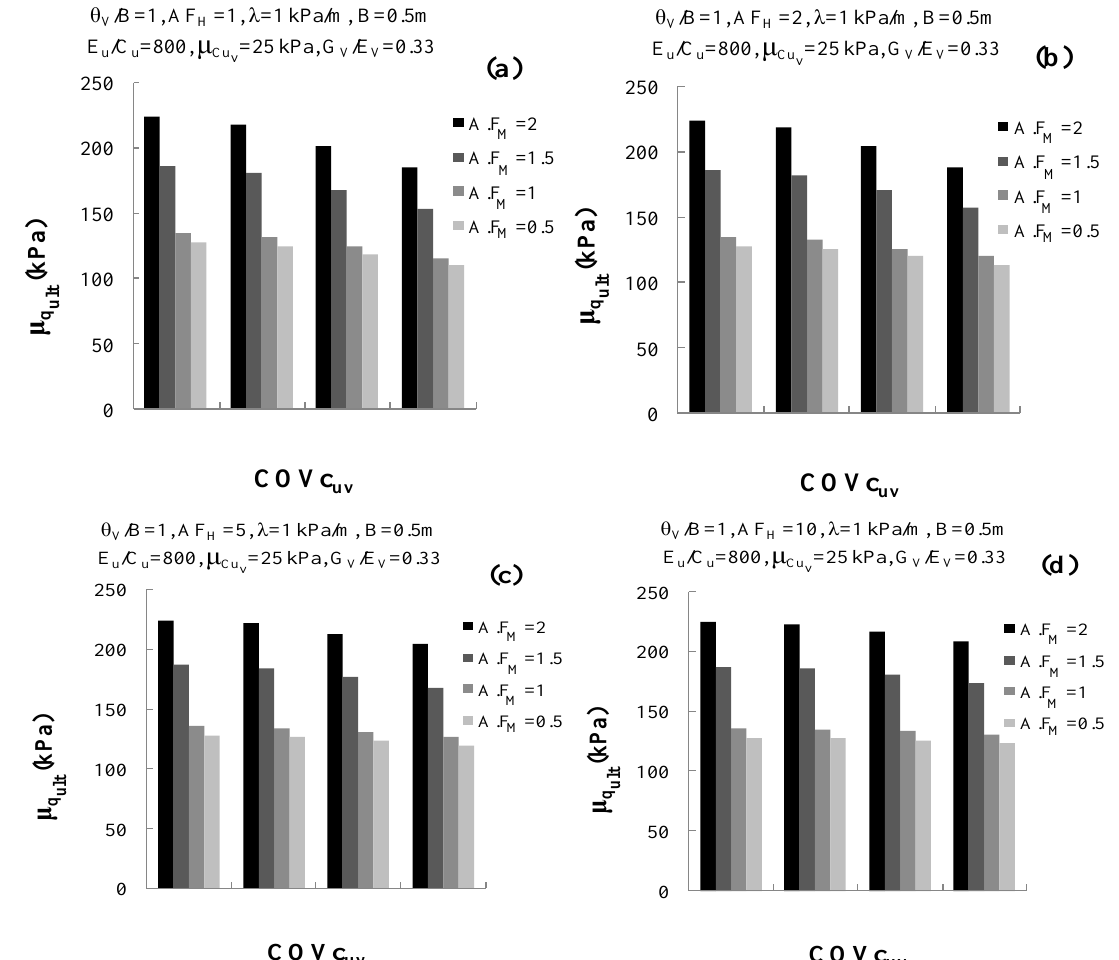
Fig. 7. Effect of A.F